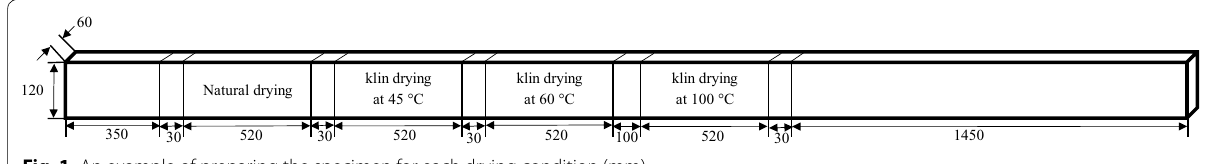
Fig. 1 An example of preparing the specimen for each drying condition (mm)